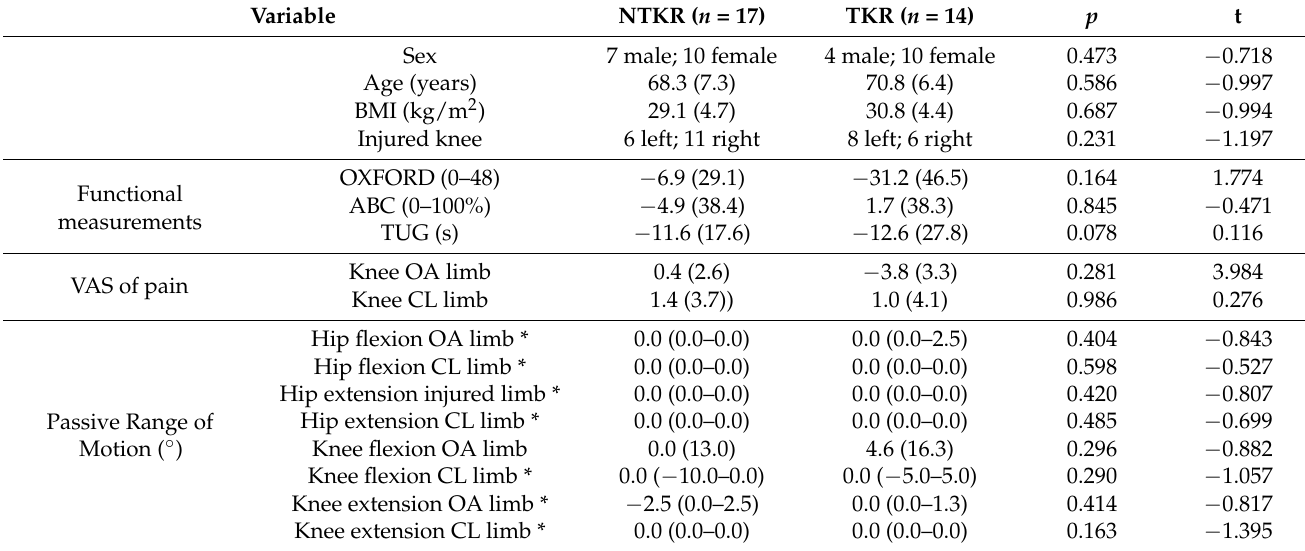
Table 1. Demographic characteristics, difference in physical and functional measurements, and pain reports of the two groups calculated by: X follow up − X Baseline . Numeric values are presented as the median and interquartile percentage. Variable NTKR ( n = 17) TKR ( n = 14)